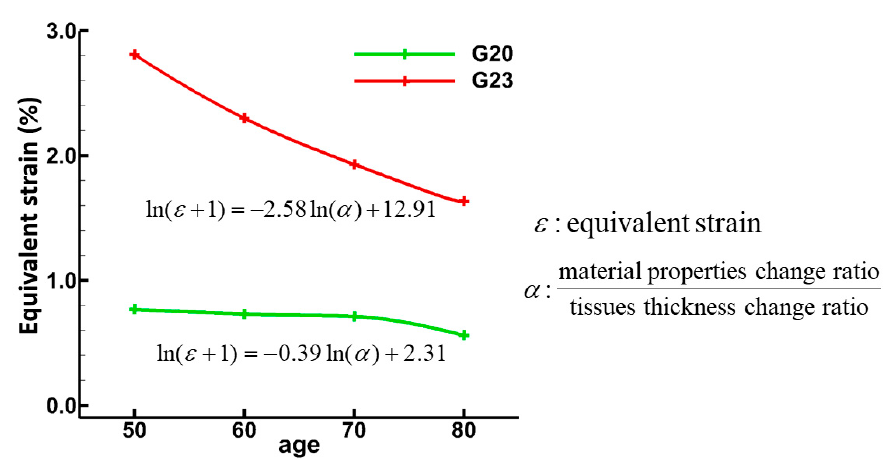
Figure 10. Material properties and tissue thickness sensitivity for normal and aged models. ε is equivalent strain and it allows any arbitrary three-dimensional strain state to be represented as a single positive value (scalar). Alpha ( α ) was defined as material properties change ratio to tissue thickness change ratio. Material properties change ratio was calculated as the smooth muscle maximum stiffness divided by epithelium minimum stiffness, and tissue thickness change ratio was calculated as the lamina propria maximum thickness divided by the epithelium minimum thickness.